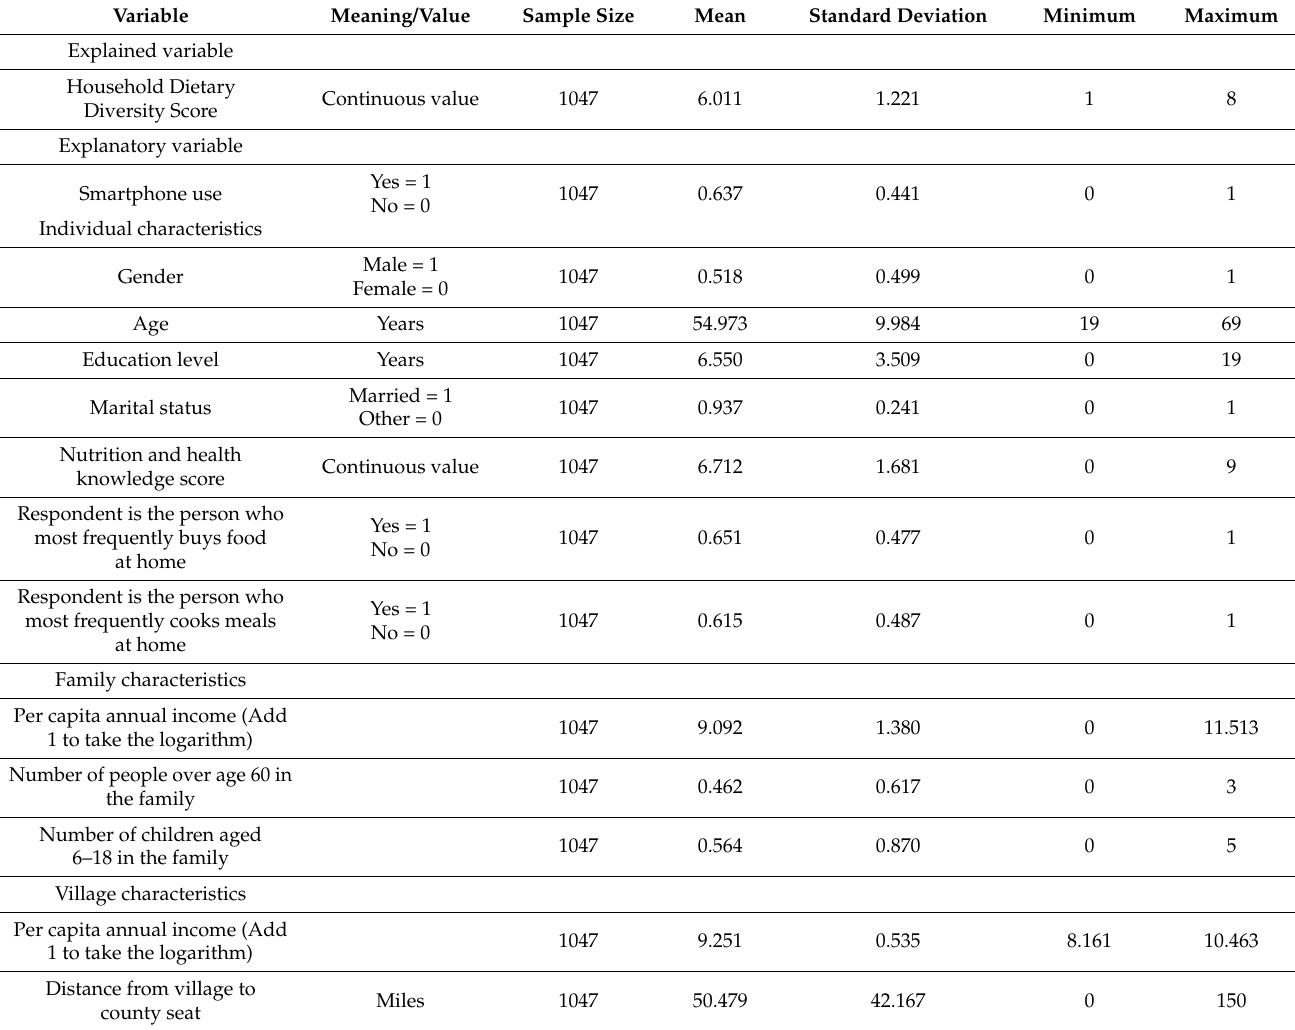
Table 1. Sample descriptive statistics.